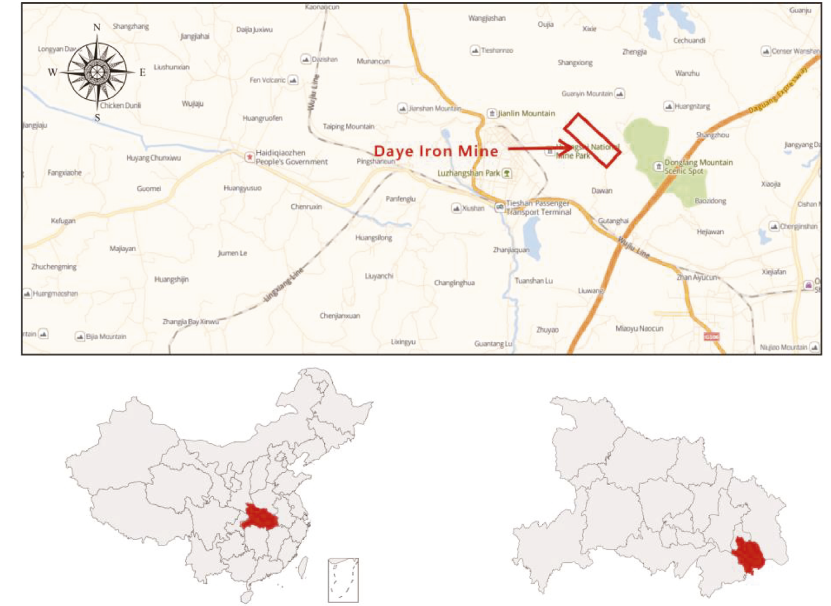
Figure 3: Location of Daye iron